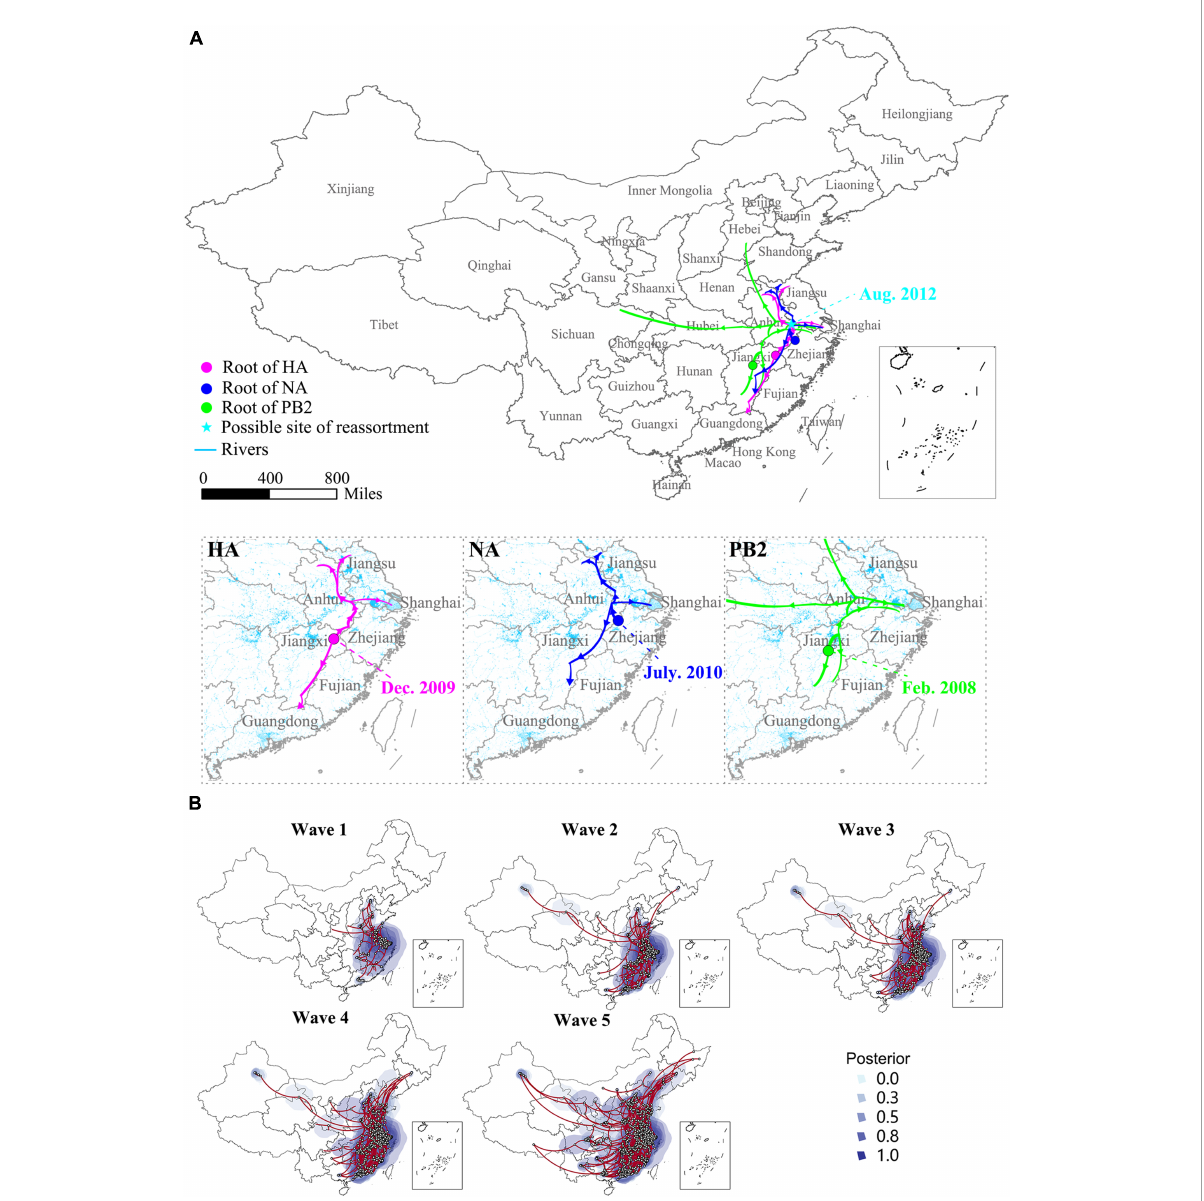
FIGURE2 Genesis and spatio-temporal spread and evolution of the H7N9 viruses. (A) Genesis and initial spreading trajectory of the H7N9 virus. The large map shows the site (indicated by the cyan star) and time of the occurrence of the reassortment event. The enlarged small maps show the occurrence and initial spread route of the ancestors of the HA, NA, and PB2 of the H7N9 virus. (B) Spatio-temporal spread and evolution of the H7N9 viruses. The spatio-temporal Bayesian evolutionary analysis was conducted based on the gene sequences of HA of the H7N9 viruses. The analysis was performed using BEAST software with the HKY nucleotide substitution model and the expansion growth with growth rate tree prior. The maps are snapshots at the end of each wave. The posterior value shows the possibility of the occurrence of a new H7N9 virus